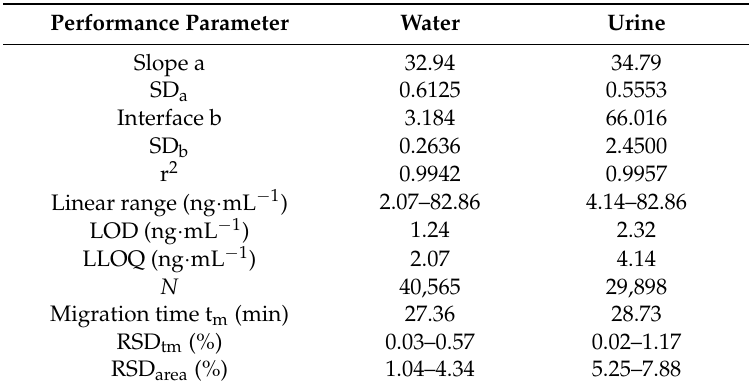
Table 1. Calibration and selected separation parameters for serotonin in model water and human urine matrices.